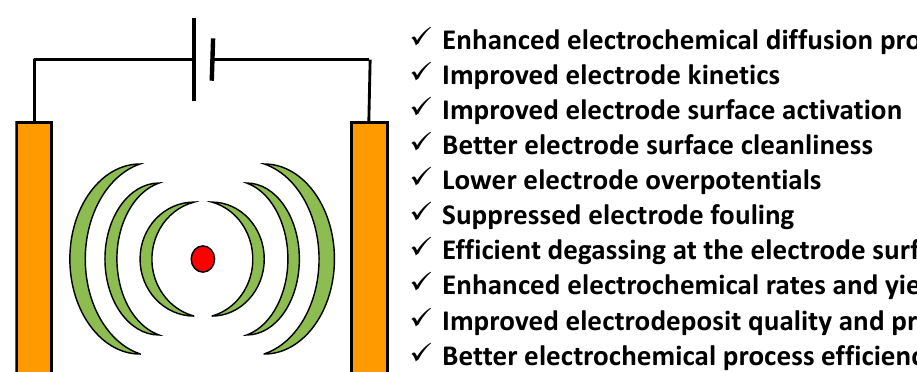
Figure 6. Short summary of the benefits of ultrasound in electrochemistry